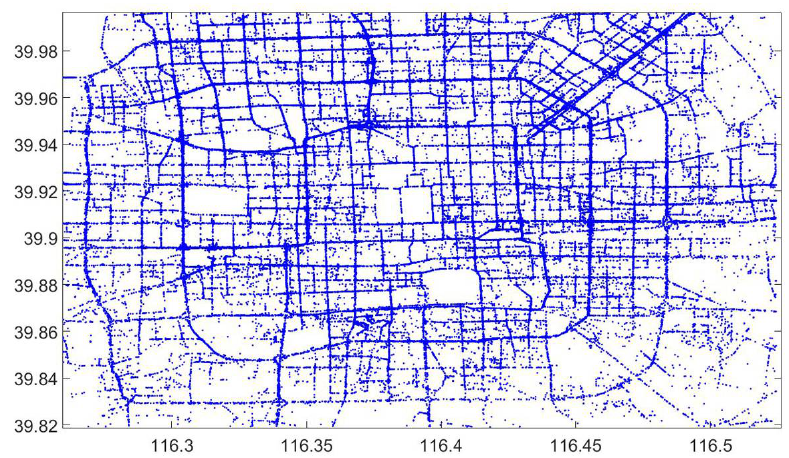
Figure 2. Road structure of the origins and destinations (OD) in Beijing using taxis’ GPS (Global Positioning System) data.